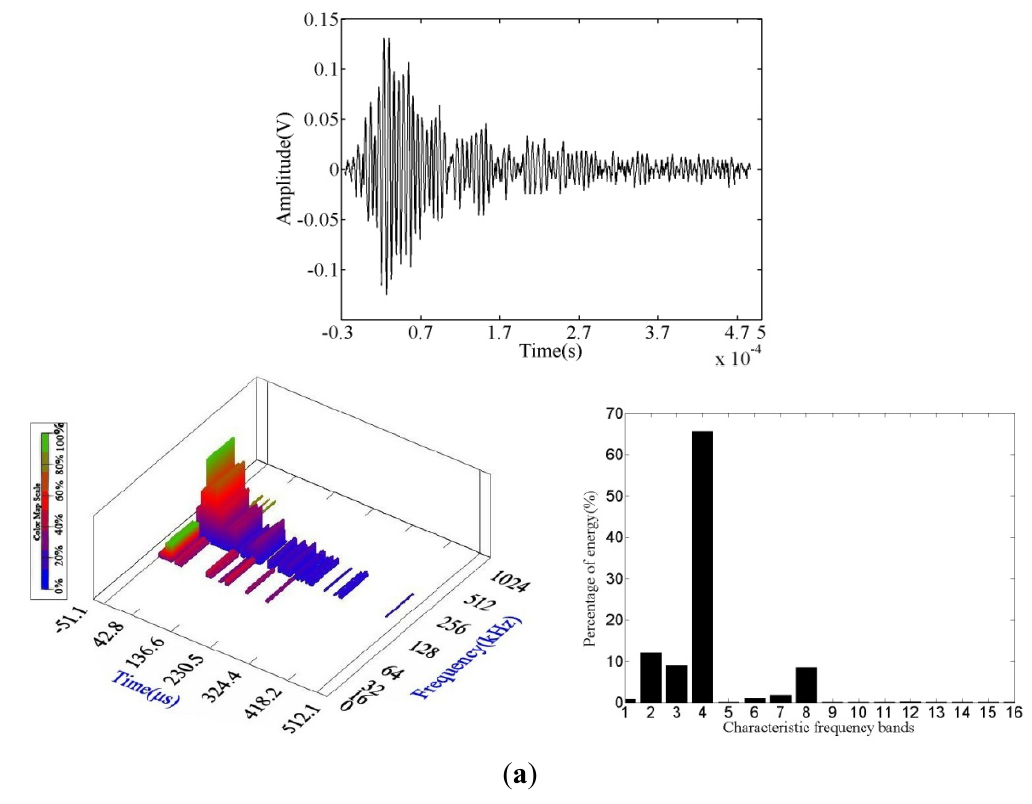
Figure 7. Fatigue crack propagation AE waveform and wavelet packet